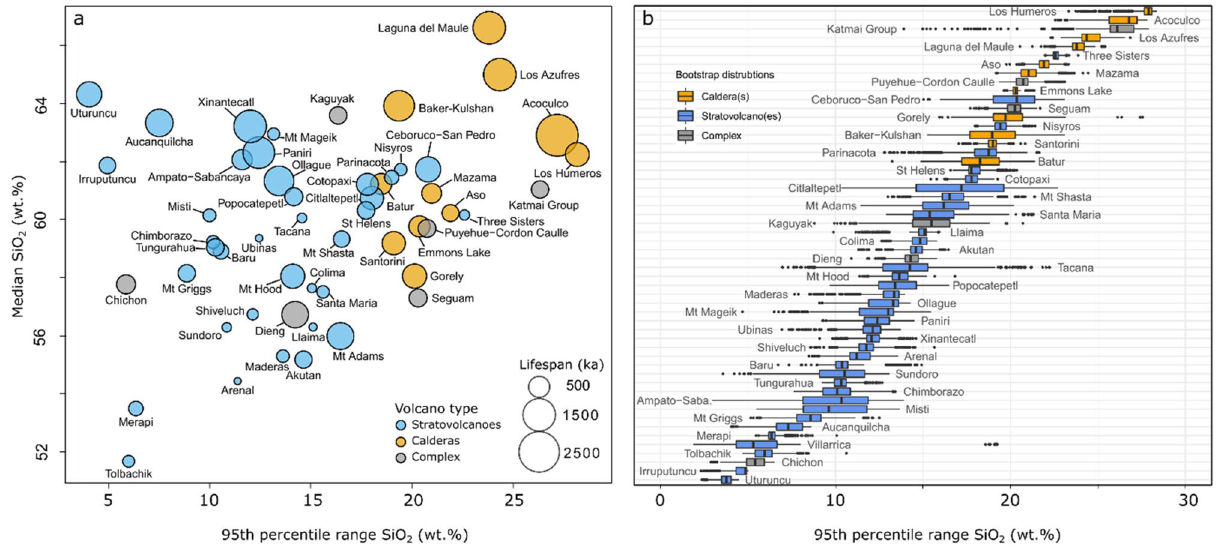
Figure 3. Spread of erupted SiO 2 bulk-rock contents (wt%) for different volcano types. ( a ) Median SiO 2 content (wt%) is plotted versus the 95th percentile range of erupted bulk-rock compositions. Different volcano types are indicated by colour: orange (calderas), blue (stratovolcanoes), grey (complex systems). The symbol size reflects the total duration of activity for each volcanic system as constrained by radiometric dating (Supplementary electronic dataset 2). ( b ) Bootstrap distributions of the 95th percentile range for the volcanic systems. The data for each volcano were resampled (‘bootstrapped’) 3000 times with replacement according to the original sample size. Boxplots show the spread of resampled distributions for each volcano and were ranked by the